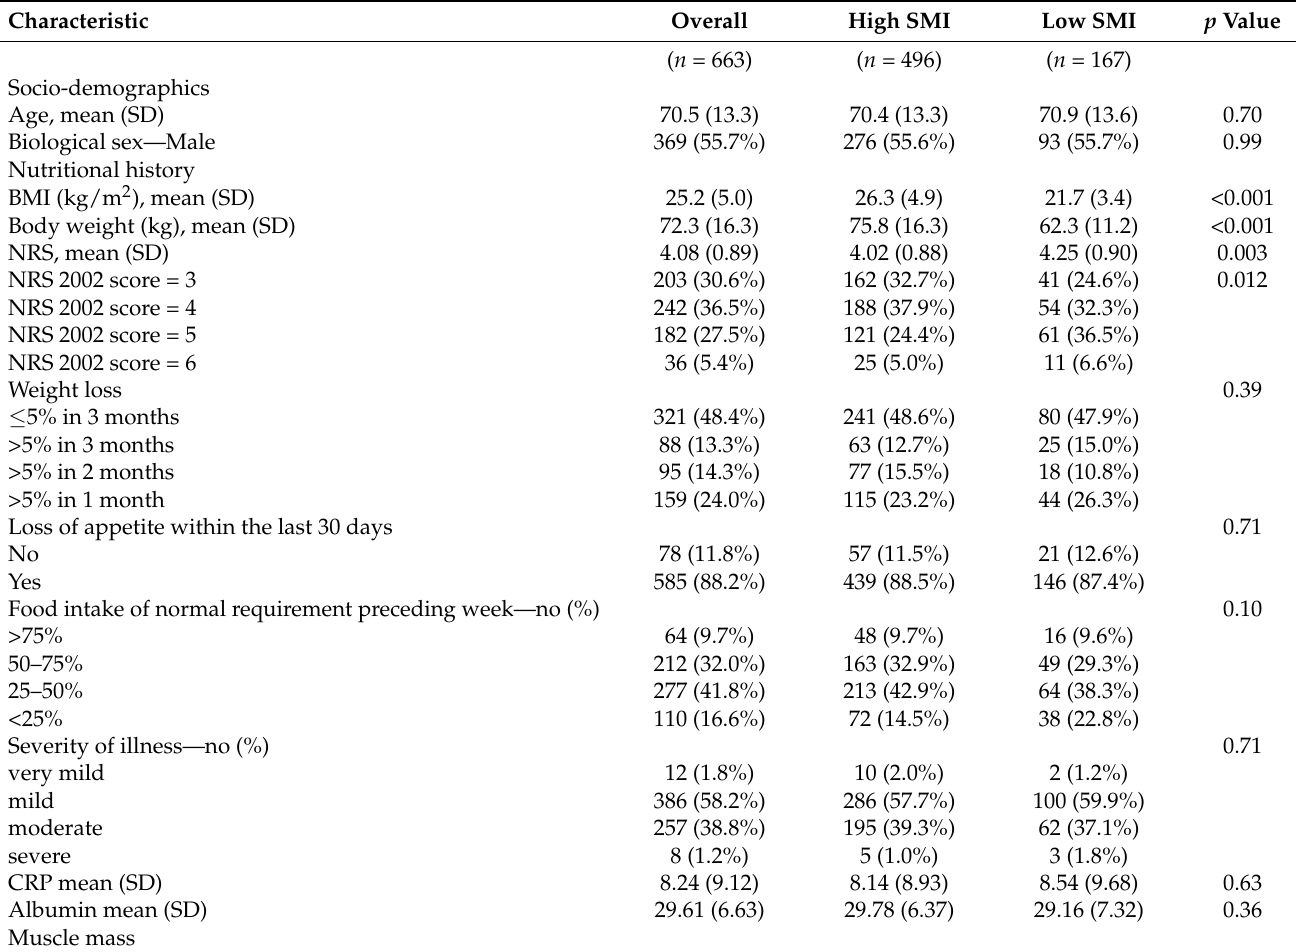
Table 1. Baseline characteristics overall and stratified by